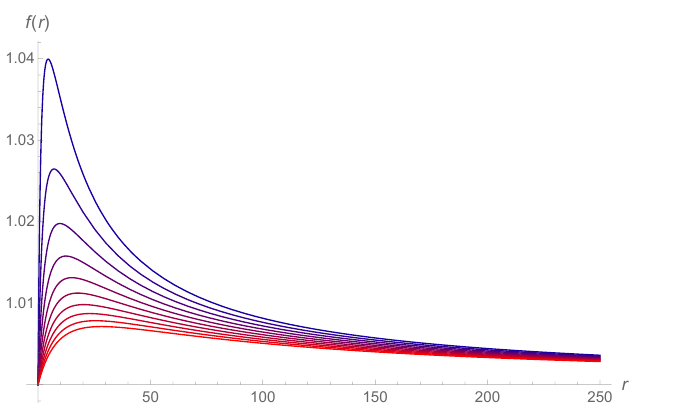
Figure 9 . Numerical solution for f for A = 1 (blue) to A = 10 (red).